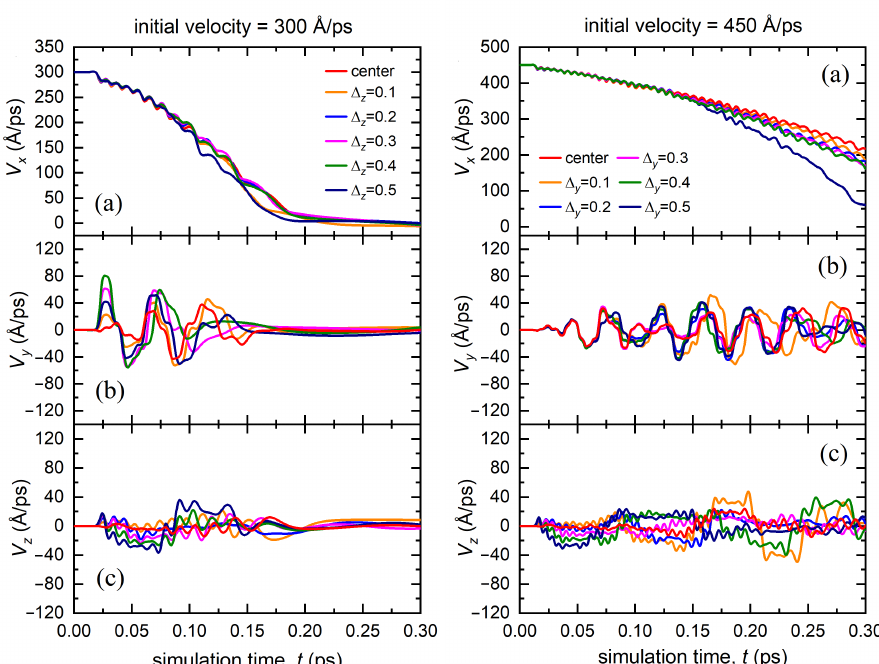
Figure 5. Dependence of the velocity components of the bombarding atom ( a ) V x , ( b ) V y , ( c ) V z on the simulation time calculated for various displacements of the atom along the z axis from the center of the octahedral channel (case IV). The results are presented for two values of the initial velocity of the bombarding atom excited according to scenario two: 300Å/ps (left panel) and 450Å/ps (right